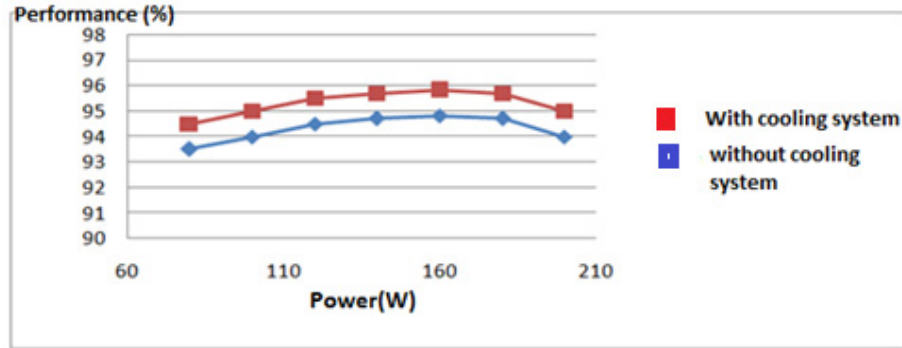
Figure 14. Efficiency with and without a cooling system.